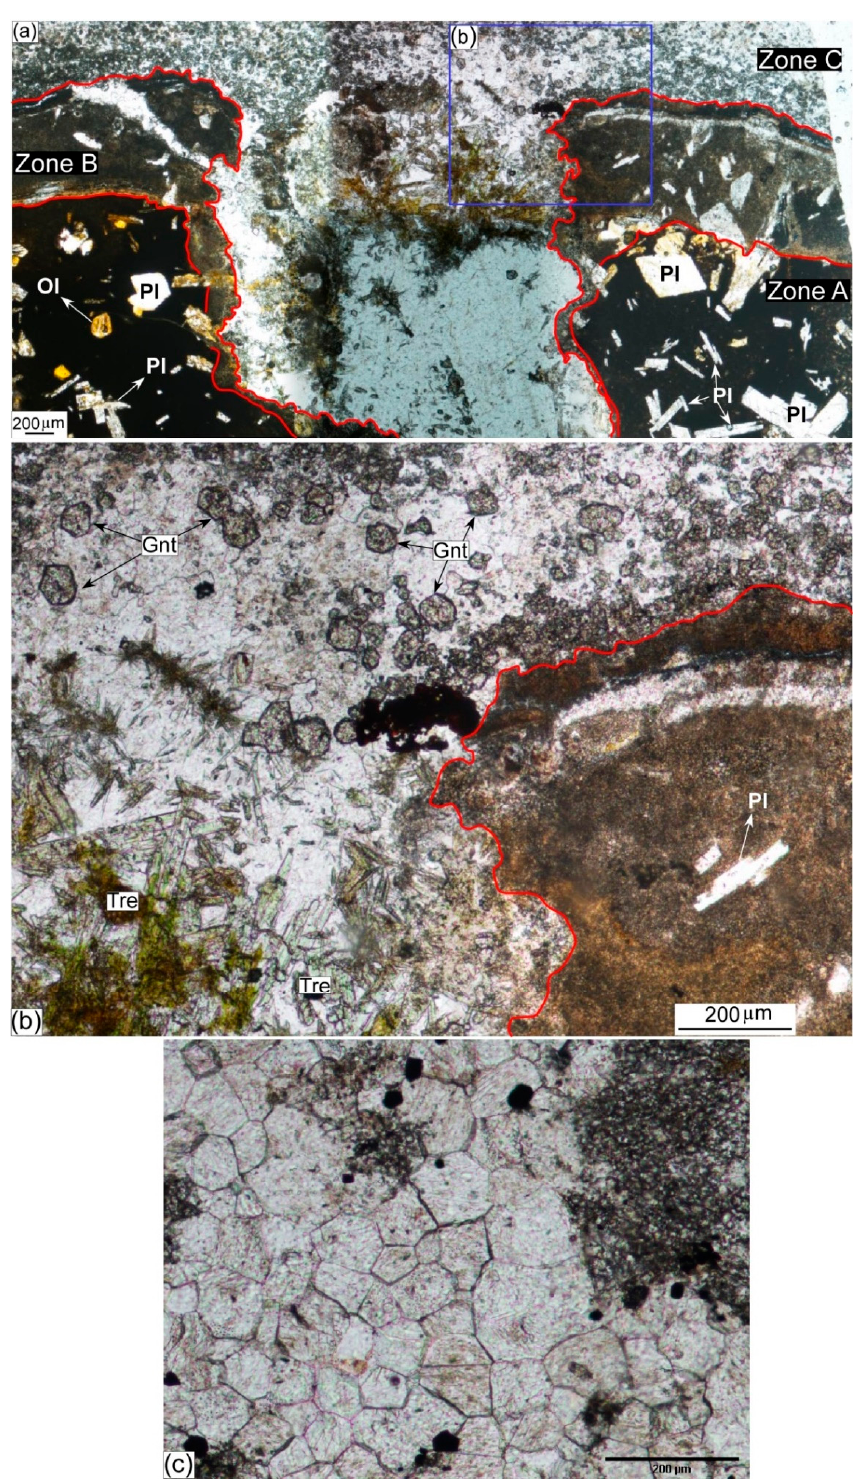
Figure 12. ( a ) Photomicrograph showing the metasomatic (zone B) and metamorphic (zone C) zones developed in contact with the vitrophyric basalt (zone A). ( b ) Close-up view of inset ( b ) in ( a ) showing the growth of the metamorphic assemblage tremolite and talc, and the metasomatic garnet in zone C. ( c ) Photomicrograph of a recrystallized limestone exhibiting equilibrium texture.